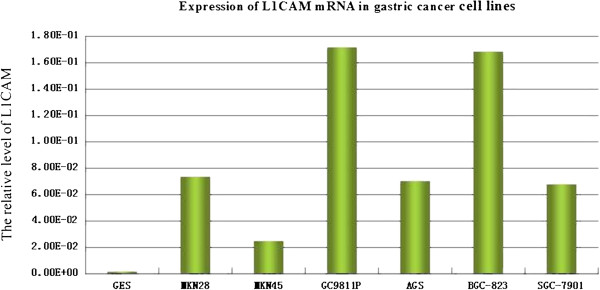
Expression of L1CAM mRNA in gastric cancer cell lines.